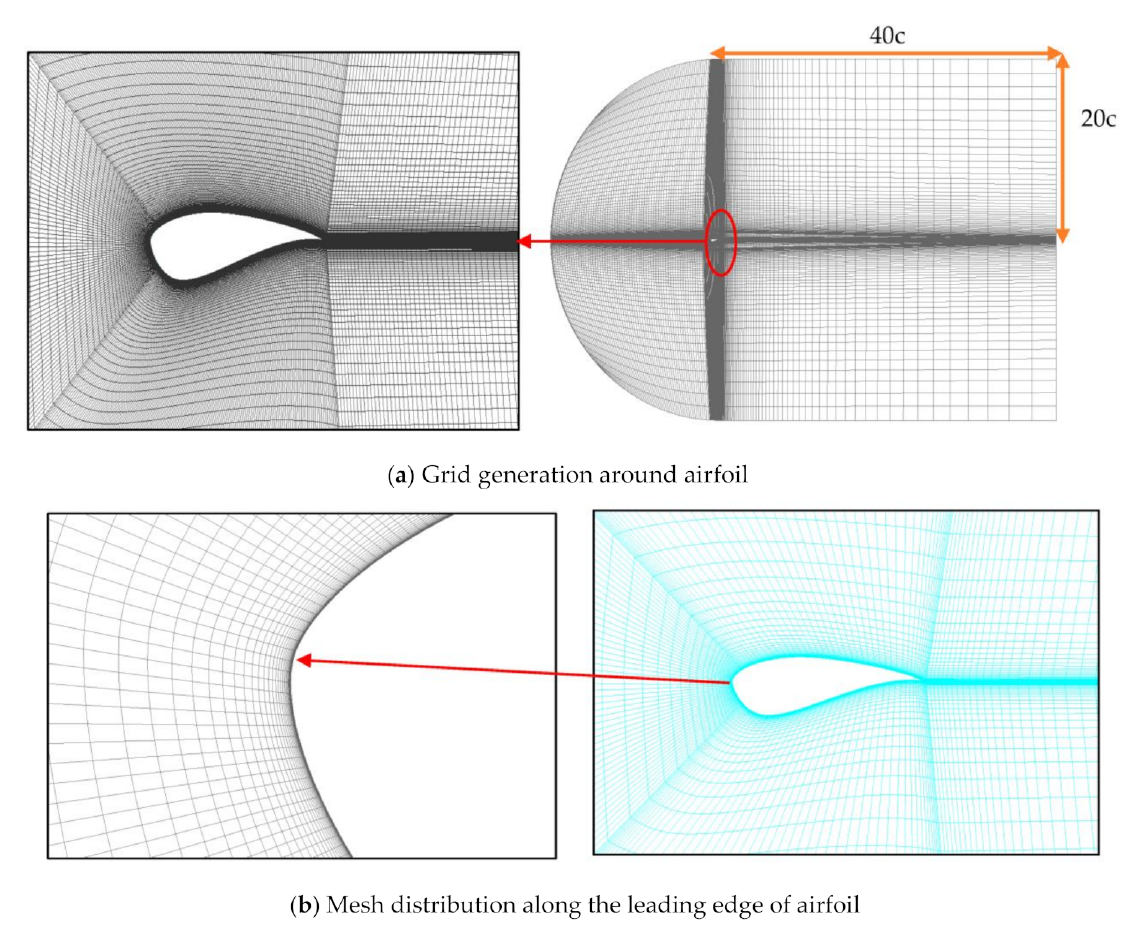
Figure 7. Meshing of the computational